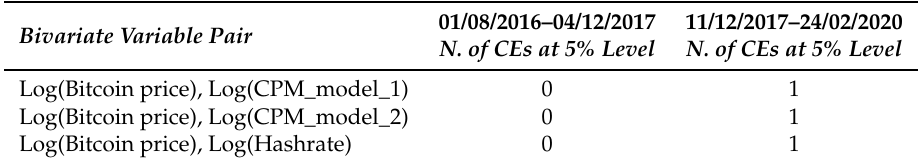
Table 4. Bivariate Johansen cointegration tests. The null hypothesis is the absence of cointegration. All the tests considered the case of an intercept in the cointegration equation (CE)